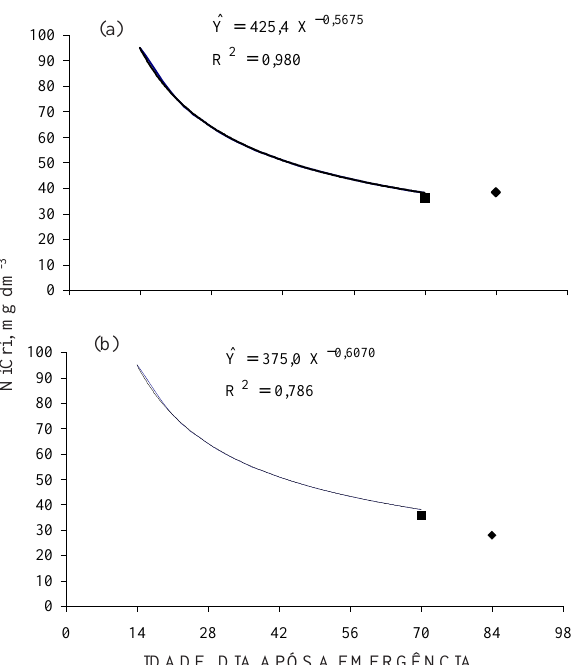
Figura 2. Variação dos níveis críticos de fósforo extraídos por Mehlich-1, de acordo com a idade das plantas de B. decumbens (a) e de P. maximum (b). Os pontos correspondem aos valores de rebrotação de 28 ( n ) e 42 ( u ) dias após 42 dias de crescimento